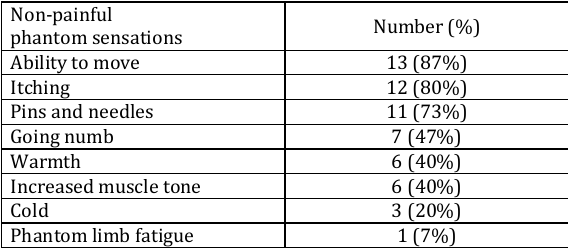
Table 4. The number and percentage of subjects experi- encing different qualities of phantom sensations (N = 15; multiple choice was